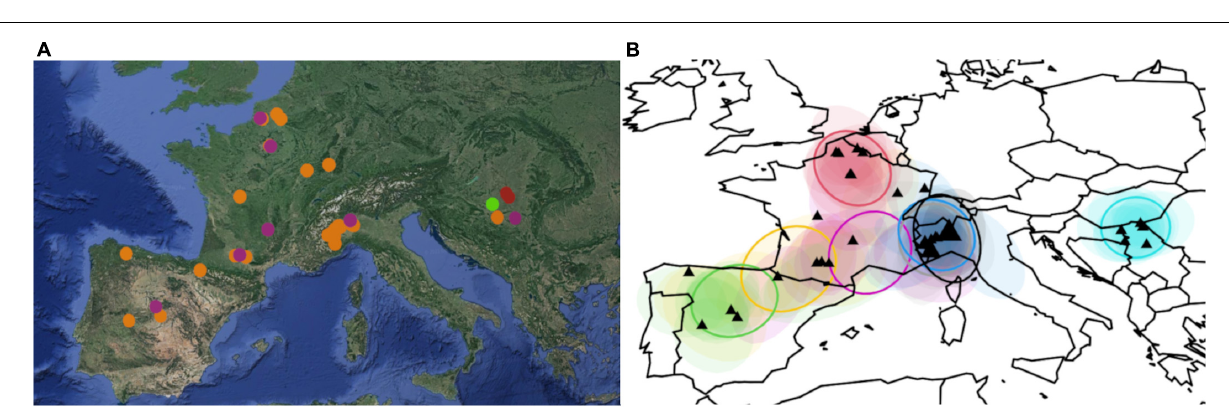
FIGURE 4 | (A) Map showing the location of the four genetic clusters identified by Bayesian analysis of population structure (BAPS) for k = 4, using the spatial model. Chart was generated by PhyloGeoViz (Tsai, 2011). Terrain image copyright by Google Earth. The colors represent the cluster to which the analyzed individuals belong based on BAPS assignment. (B) Cluster analysis built by the Bayesian phylogeographic and ecological clustering. Each colored areas indicate a different phylogeographic